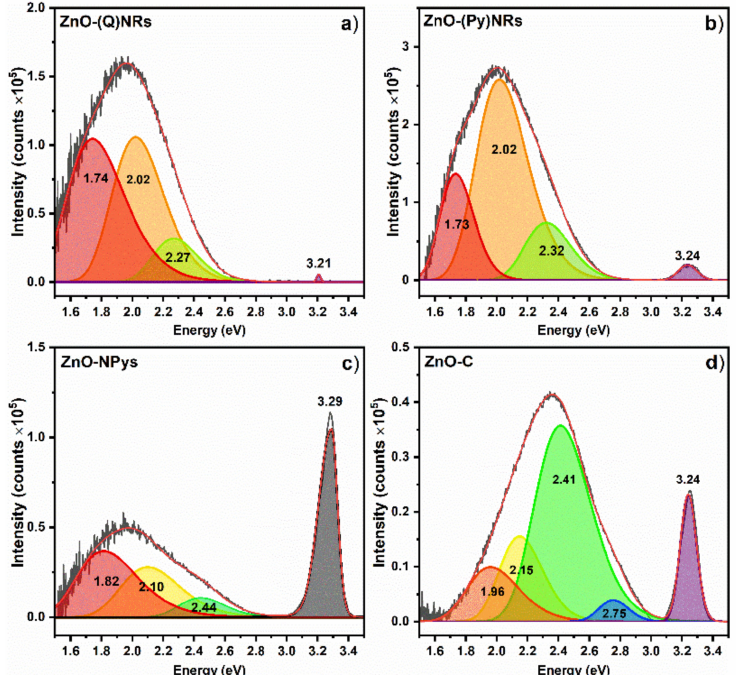
Figure 6. Photoluminescence spectra of pristine ( a ) ZnO-(Q)NRs, ( b ) ZnO-(Py)NRs, ( c ) ZnO-NPys, and ( d ) ZnO-C. Excitation wavelength: 300